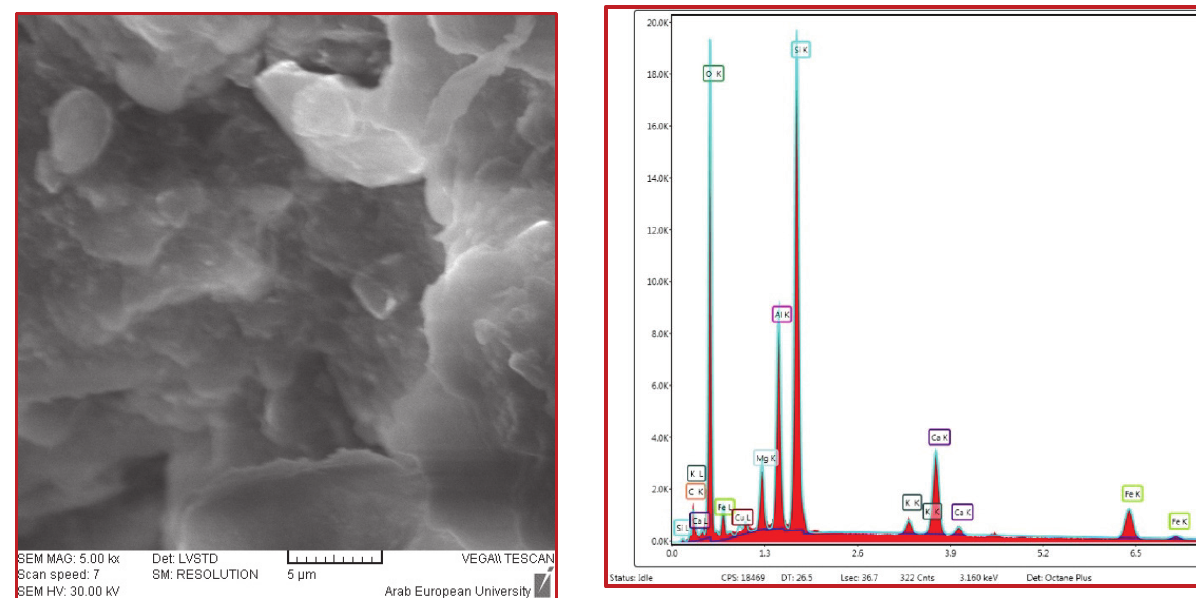
Figure 9. SEM micrograph and EDX analysis of natural soil 2 cured for 7 days. Figure 9: SEM micrograph and EDX analysis of natural soil 2 cured for 7